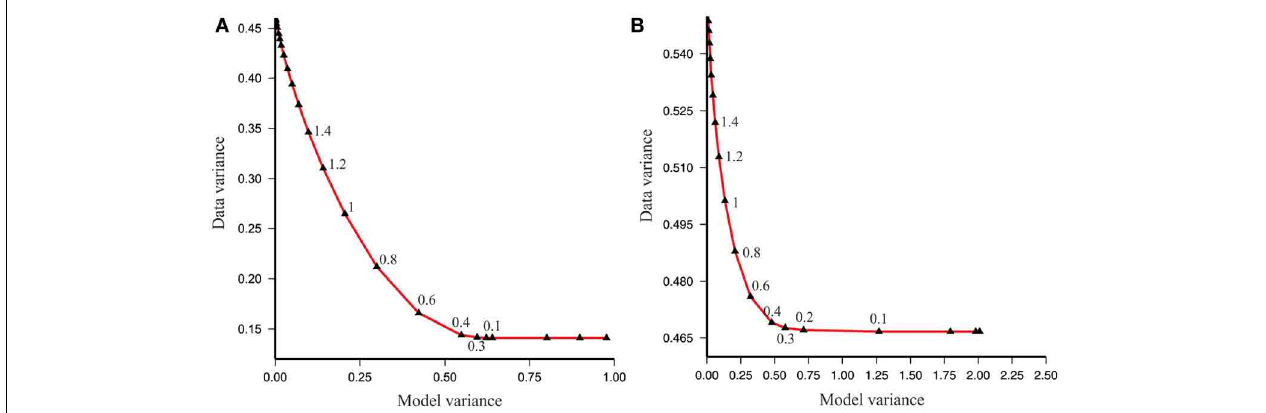
FIGURE 2 | Trade-off curve between the data variance and the model variance for the full range of possible values of the damping parameter e . Number close to each black triangle denote the value e